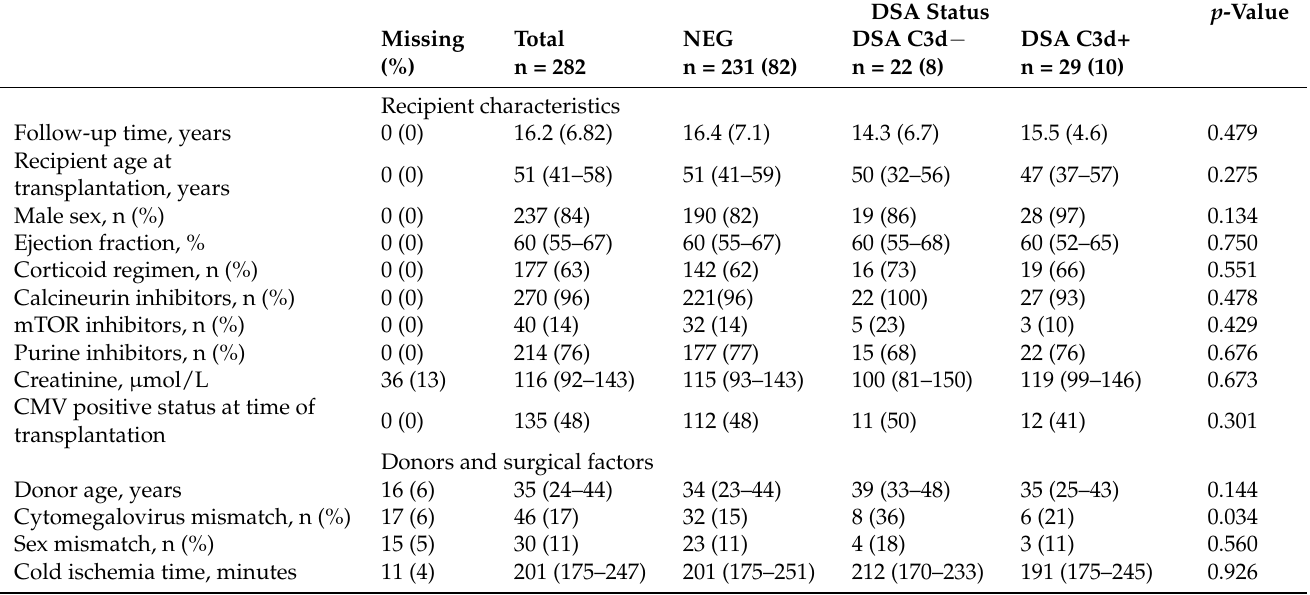
Table 1. Recipients, donors, and surgical factors according to DSA status.